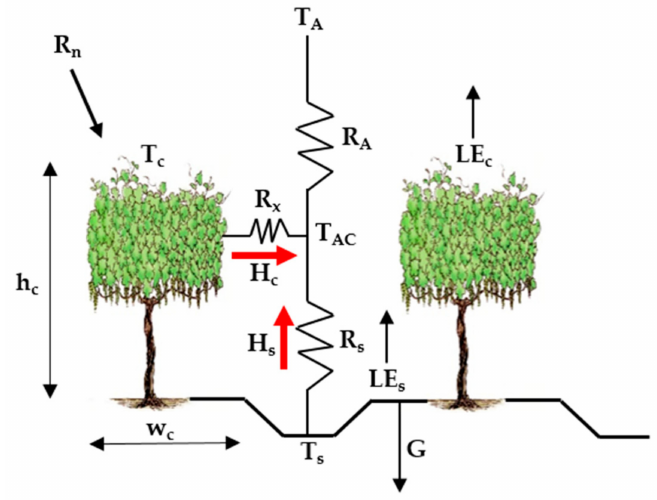
Figure 1. Schematic representation of the Two-Source Energy Balance ( TSEB )